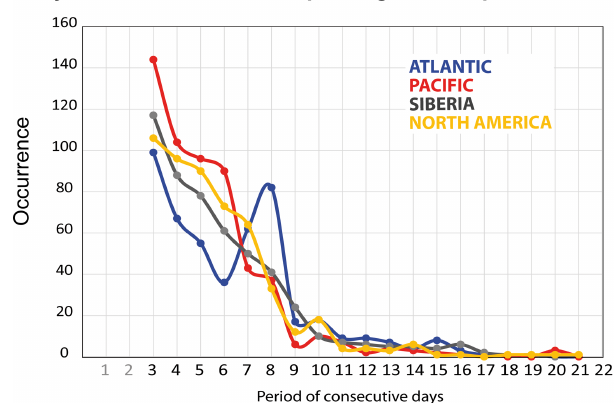
Figure 7. Histograms of the moisture transport for precipitation (MTP) extremes for each source according to their